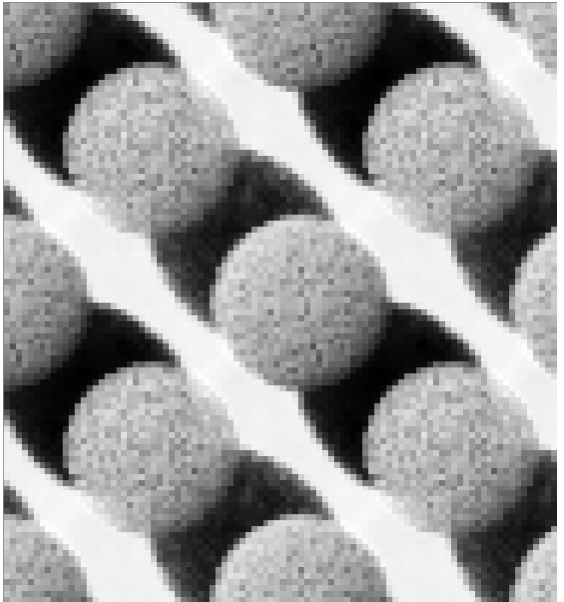
Figure 5. Nadir view of a DART sample scene that is used to represent the heterogeneous canopy. The centre scene with five trees is replicated along the edges. Colour is reflectance with low values black and high values